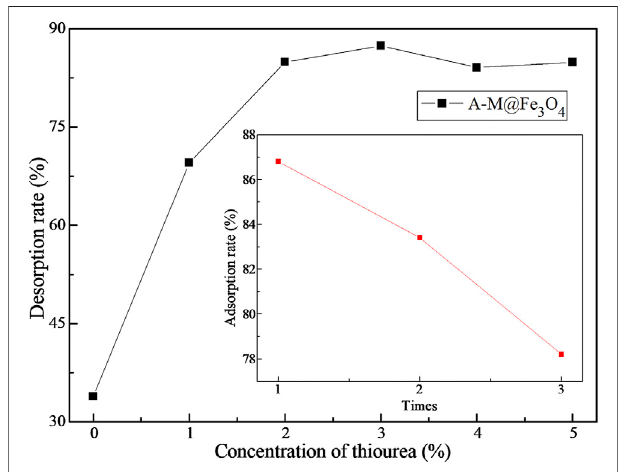
FIGURE6| Theeffectofthioureaconcentrationonthedesorptionrateof Hg(II) and the elution regeneration adsorption rate of A-M@Fe 3 O 4 (inset).